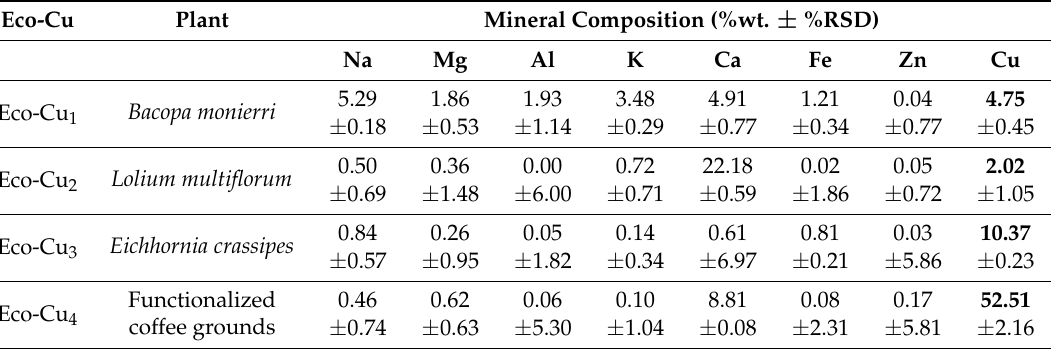
Table 3. The mineral compositions of the different